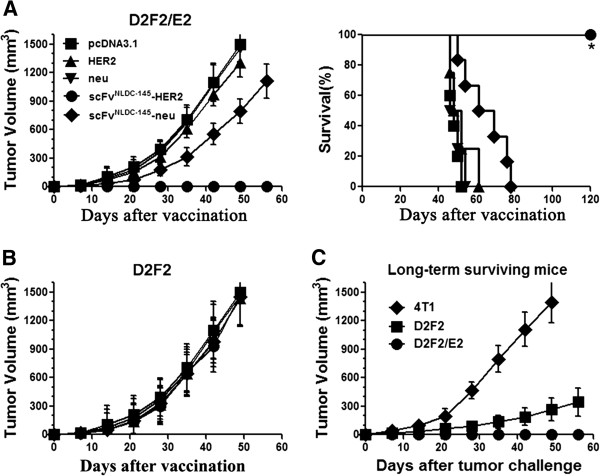
Vaccination with scFvNLDC-145-HER2 protects mice from challenge with HER2-expressing tumor cells and induces memory immune responses. A animals (10 mice per group) were vaccinated with HER2, neu, scFvNLDC-145-HER2 or scFvNLDC-145-neu on days -21 and -7. Control animals received pcDNA3.1. On day 0, mice were inoculated s.c. with D2F2/E2 tumor cells. Tumor developments were monitored, and animal survival was calculated. Left panel, kinetics of tumor growth; Right panel, survival curve. B the vaccinated animals were challenged with parental HER2-negative D2F2 cells on day 0. C the long-term surviving mice from scFvNLDC-145-HER2 group were rechallenged with D2F2/E2, D2F2, or syngeneic unrelated 4 T1 tumor cells 3 months after initial tumor challenge. Tumor growth was followed. Bars, SE. *, P < 0.001, scFvNLDC-145-HER2 compared with other groups.